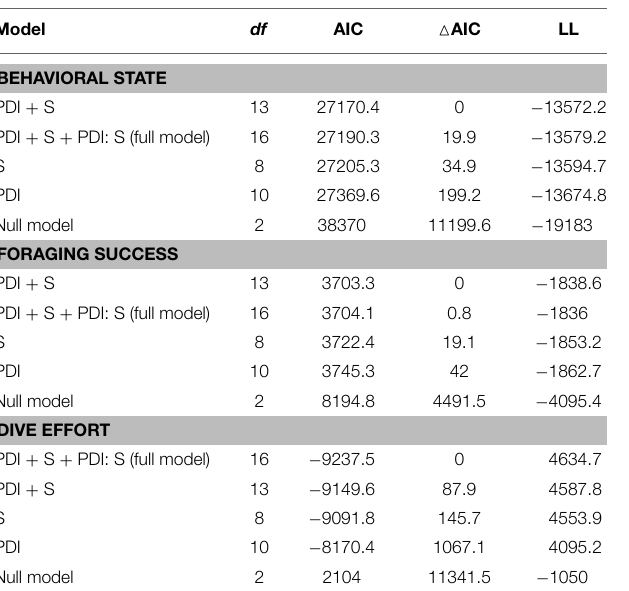
TABLE 1 | Ranked model parsimony according to the significance of fixed effects (plankton density index—PDI; season—S) and their interaction term (PDI: S) in relation to each behavioral metric.